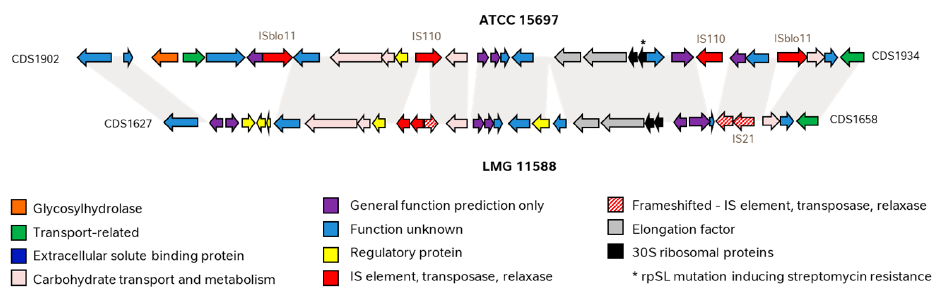
Figure 3. Comparison of the genomic organization surrounding the rpSL gene of B. longum subsp. infantis ATCC 15697 and LMG 11588. Homologous DNA portions are indicated in grey. Functional classes are represented by different colors. Table 6. Significant BlastP hits for putative enzymes implicated in the production of harmful metabo- lites in B.infantis ATCC 15697 and LMG 11588